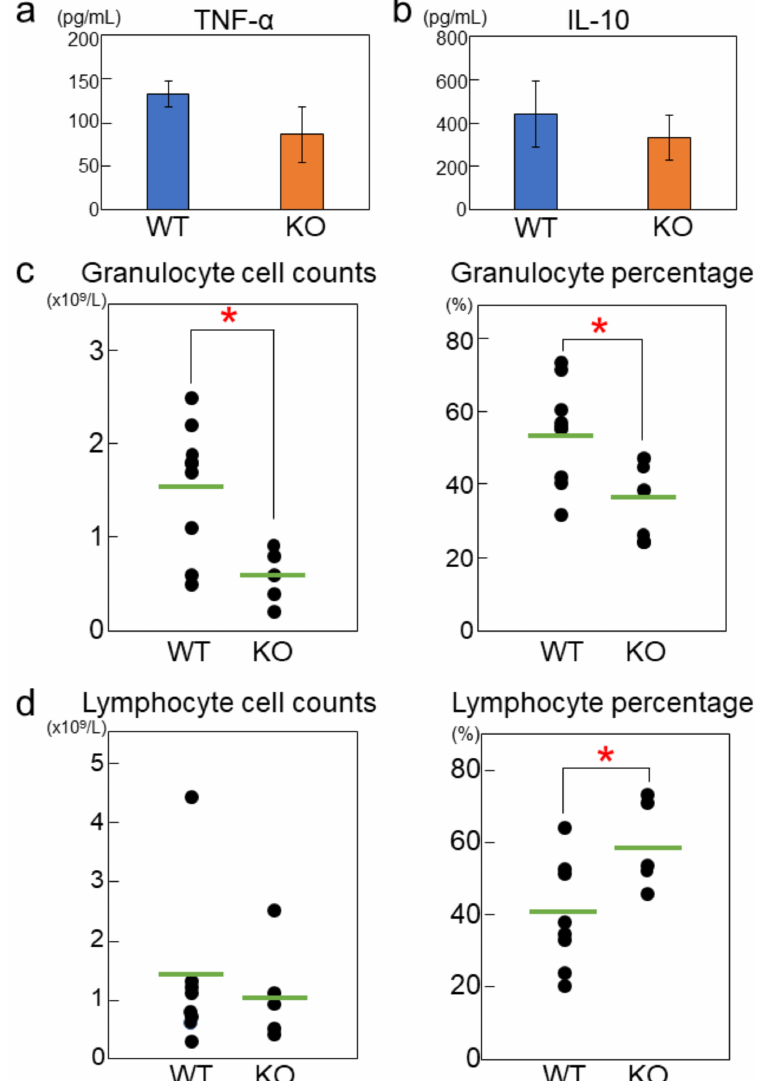
Figure 2. Different immune responses between wild-type (WT) and Rab44-knockout mice (KO) to LPS administration. ( a , b ) WT and Rab44-KO female mice were intraperitoneally injected with 0.2 mg of LPS (O55:B5). After the injection, blood was collected from the mandibular or tail vein at 12 h. The cytokine levels of TNF- α ( a ) and IL-10 ( b ) in the sera were measured using ELISA. ( c , d ) After 48 h of injection, the blood was analyzed with a hematology counter, Thika (ARKRAY) (WT, n = 8; KO, n = 5). * p < 0.05 compared between WT and KO mice. Granulocytes ( c ) and lymphocytes ( d ) counts (left panels), and percentages in white blood cells (right